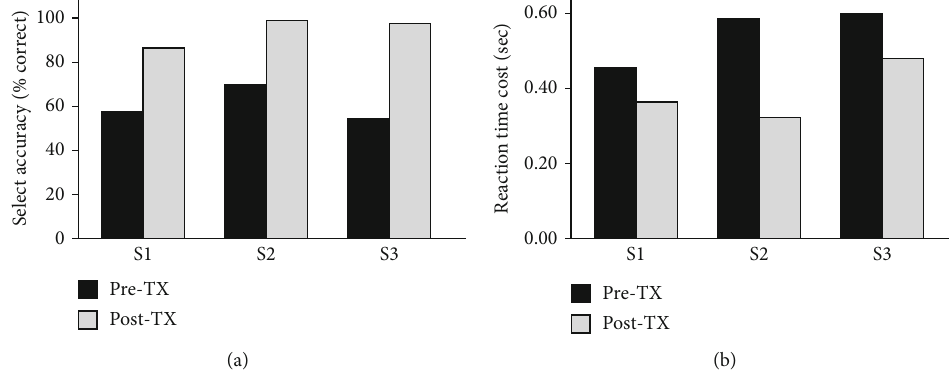
Figure 4: Select performance on the action selection brain-behavioral probe task before (Pre-TX) and after (Post-TX) training. Select accuracy (a) represents responses in the correct direction (right/left); reaction time cost (b) represents the increase in reaction time to complete the Select condition compared to the Execute condition (Select RT-Execute